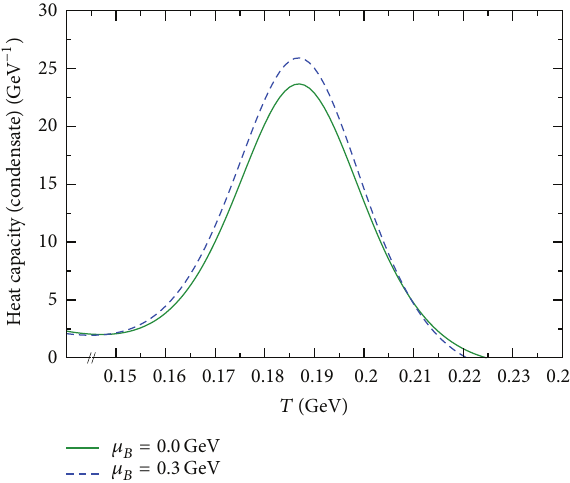
Figure 24: Heat capacity for the quark-condensate as a function of = 0 (solid line) and 𝜇 = 300 MeV (dash line). The critical 𝑇 for 𝜇 𝐵 𝐵 temperature 𝑇 𝑐 corresponds to the maximum of the heat capacity for a given value of 𝜇 𝐵